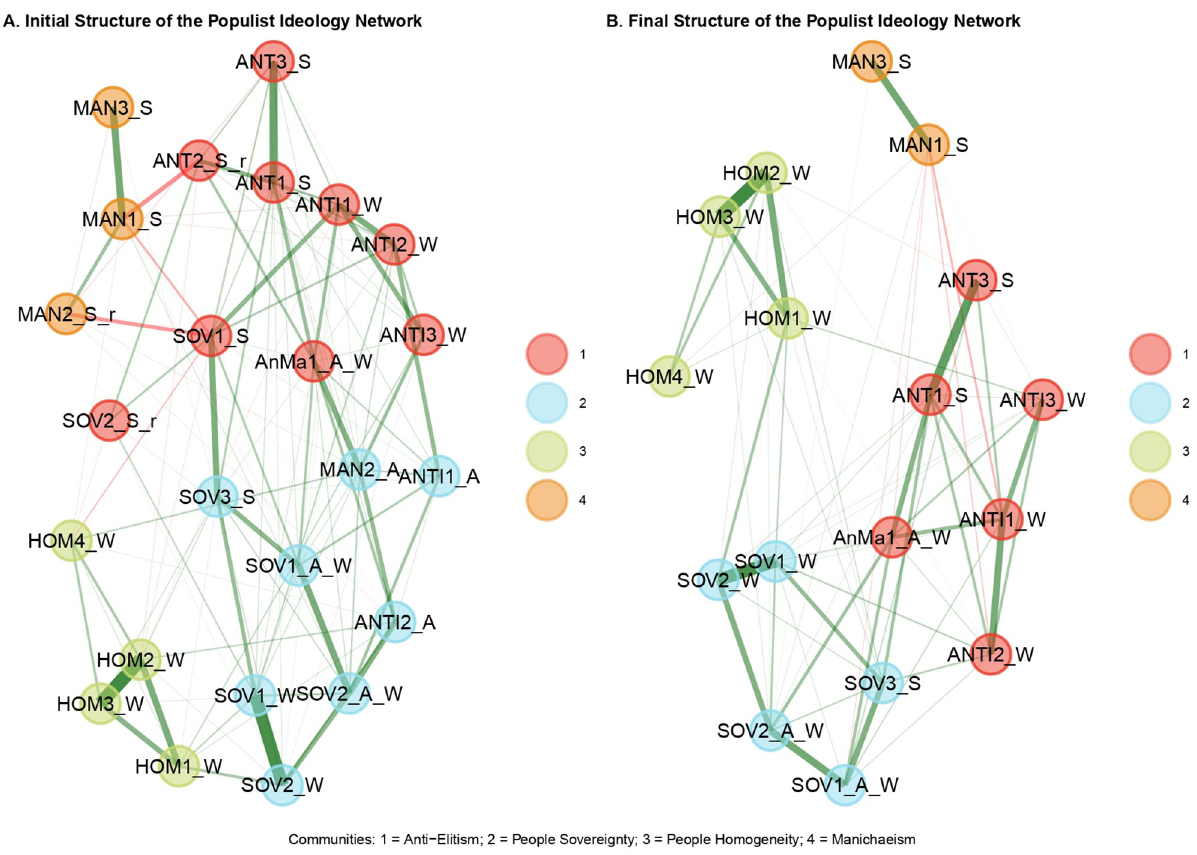
Fig 1. Network structure of populist ideology. (A) Initial solution of populist ideology network resulting from the EGA model. (B) Final solution of populist ideology network after removing unstable items from the EGA model.